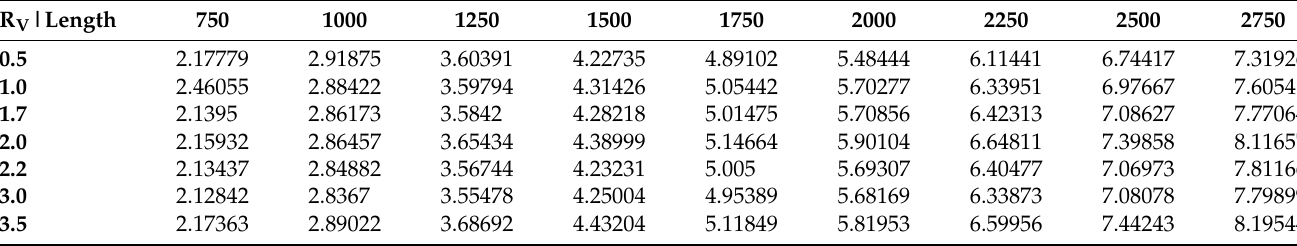
Table A6. Execution times in milliseconds on CPU with cable structure for 20,000 time-steps (1.0 S); R V on the Left and number of cells (length) on the Top .